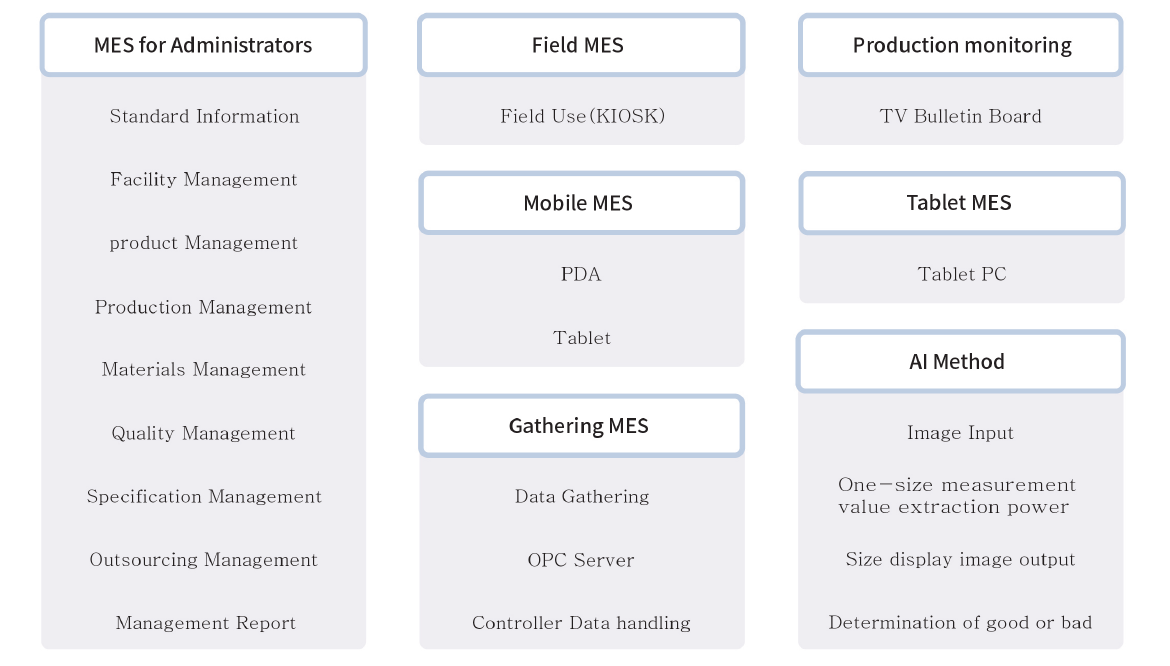
Figure 12. A functional diagram of the